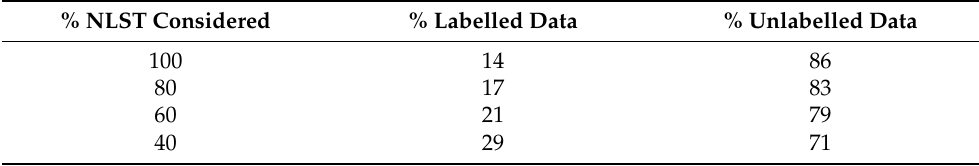
Table 4. Proportions of labelled and unlabelled data for different NLST data percentages.